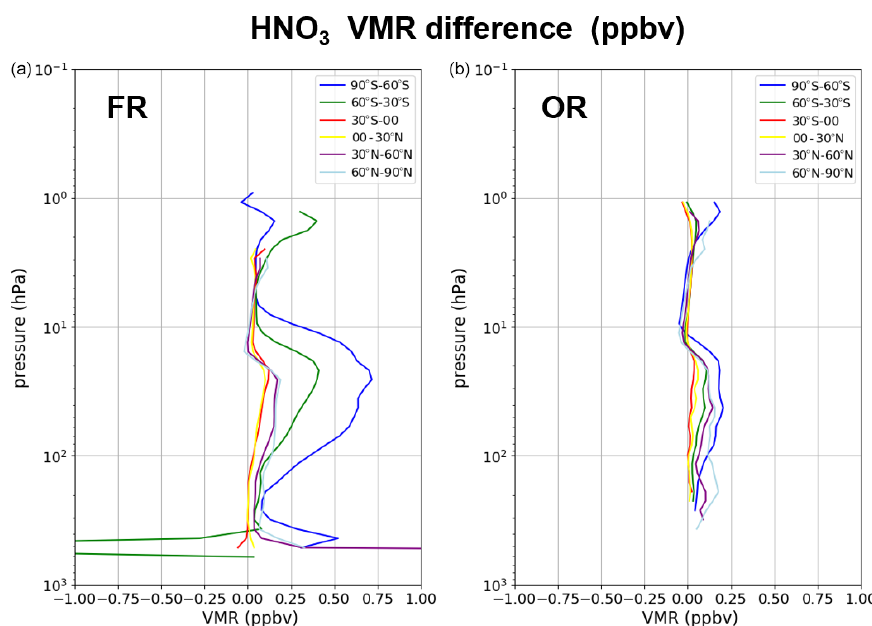
Figure 10. Absolute difference between the mean HNO 3 profiles retrieved using the new (mipas_pf4.45) and the old (mipas_pf3.2) spec- troscopic databases at different latitude bands for selected orbits in the full resolution (FR) phase (a) and in the optimised resolution (OR) phase (b) .